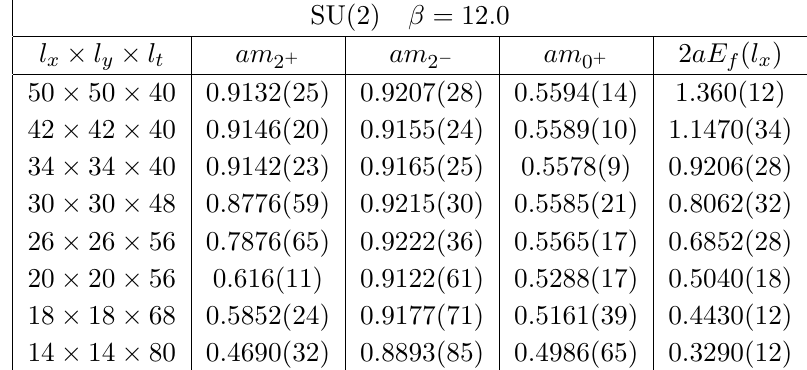
Table 1 . Lightest J P = 2 + ; 2 (cid:0) ; 0 + glueball masses on various l x (cid:2) l y spatial lattice volumes. Also the energy E f ( l x ) of the lightest fundamental (cid:13)ux tube that winds around the x -torus. In SU(2) at an inverse bare coupling (cid:12) = 4 =ag 2 = 12 :